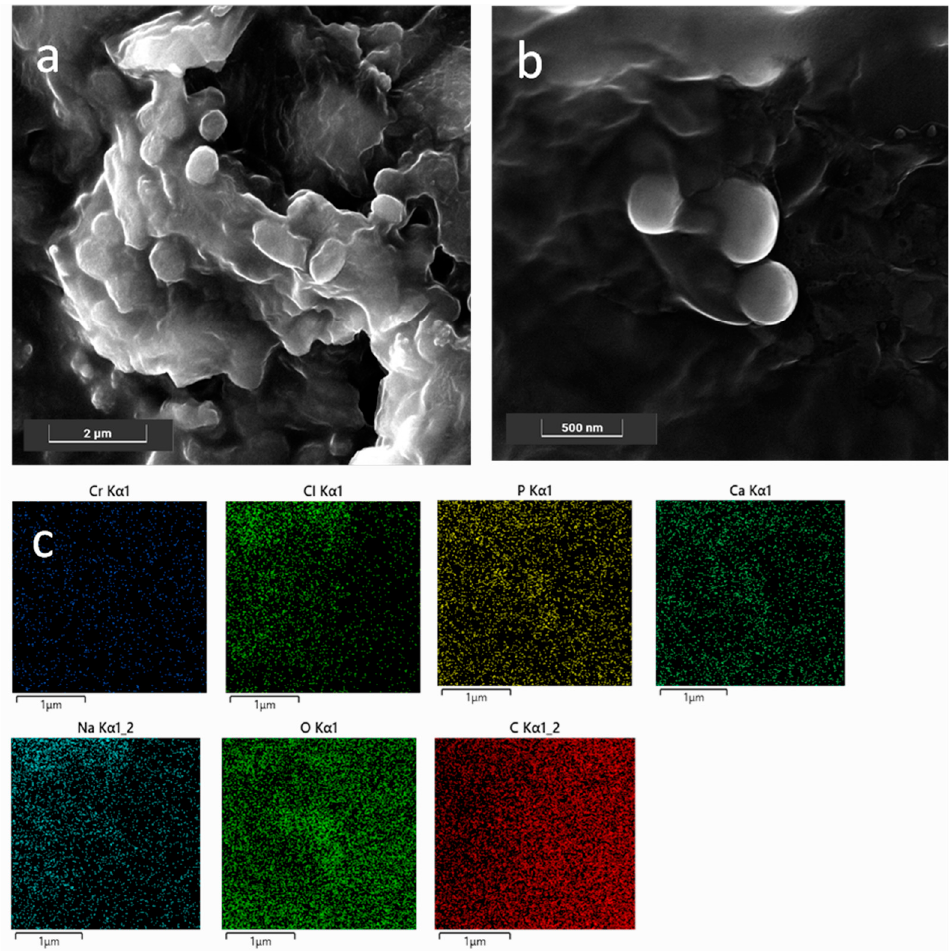
Figure 1. FESEM representative images of bare NPs ( a ) and CaP Ca -NPs ( b ); EDS maps of the region shown in ( b ) for Cr, Cl, P, Ca, Na, O, and C ( c ). Images were collected at 10 kV with the standard SE